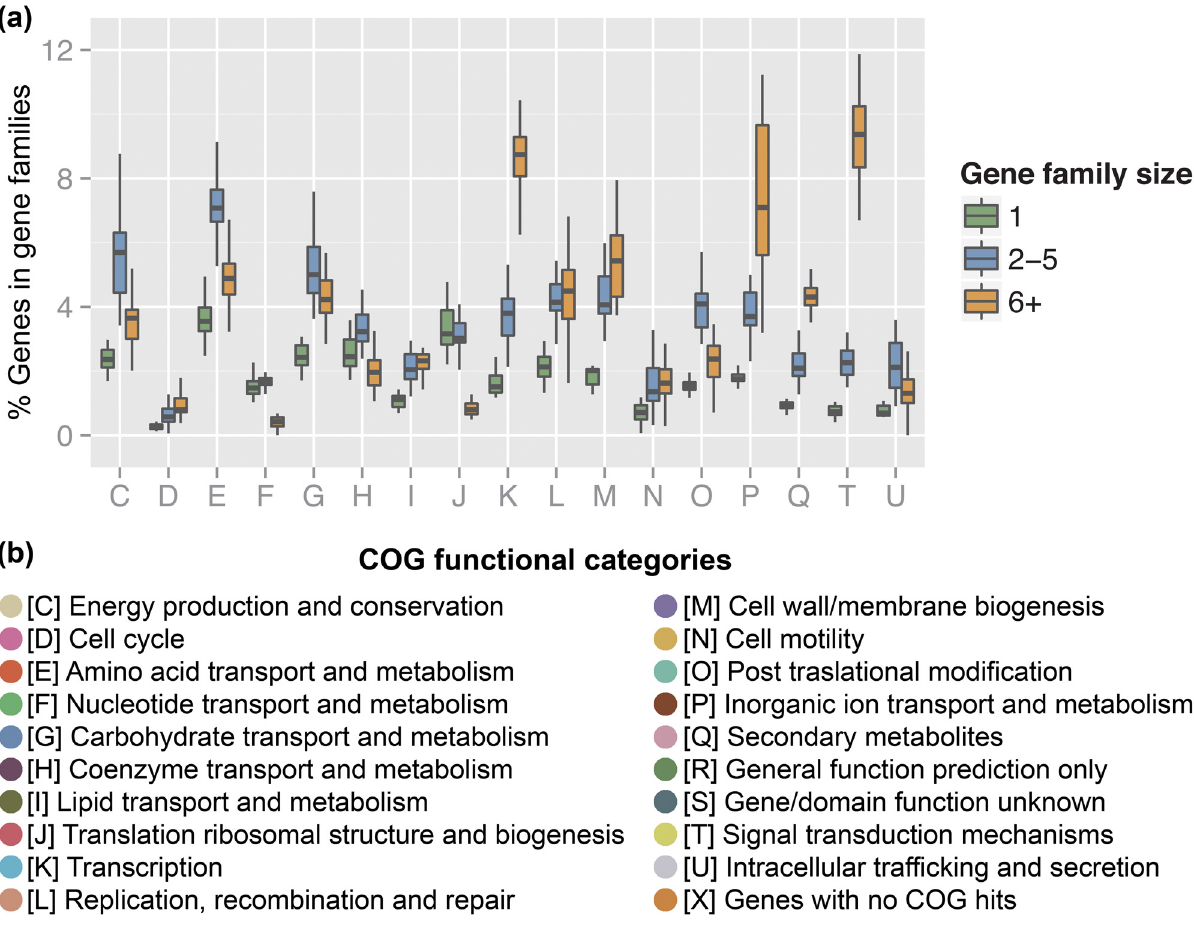
Fig 2. Distribution of COG functional categories in paralogous gene families. (a) Distribution across families containing only singletons, or with 2 – 5 members or 6+ members. Paralogous gene families were identified using a network-based approach (see S1 Text). (b) Definition of COG categories on the x-axis of (a) (and also in S4